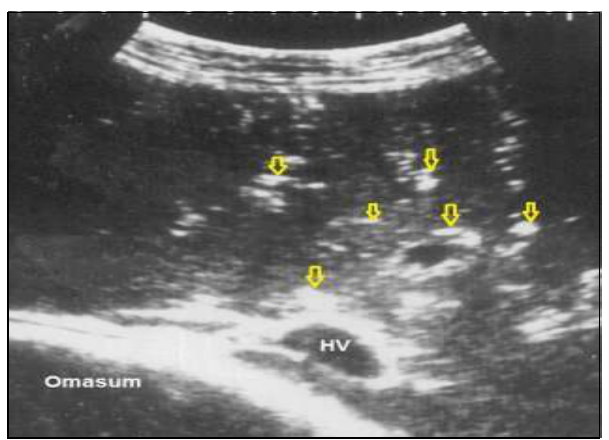
th Figure-2: Ultrasonography of liver at right 7 ICS shows a